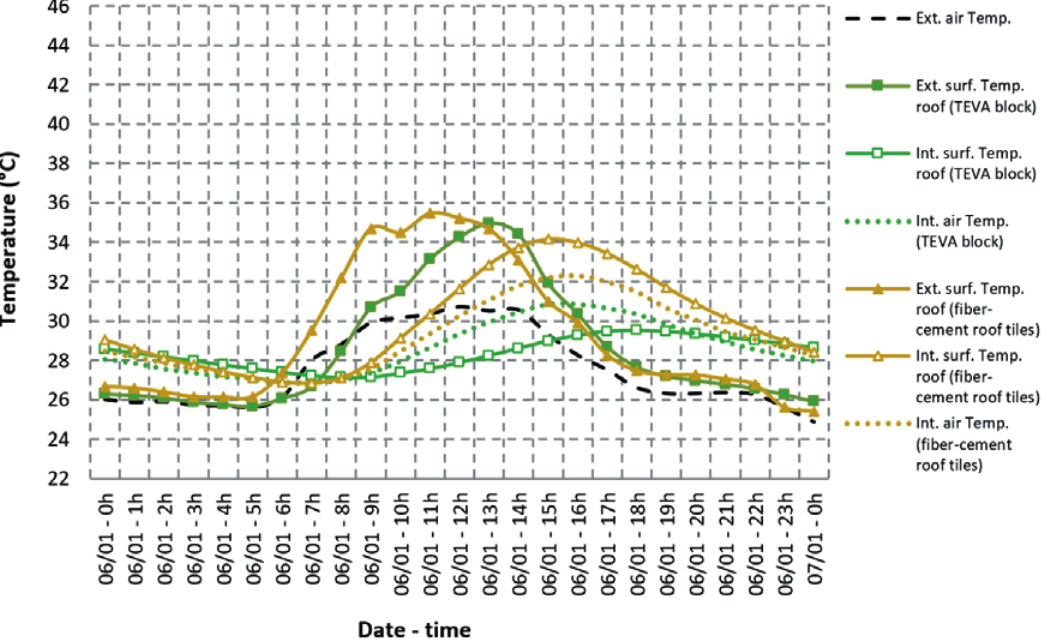
Thermal behavior of the prototype with a green roof with TEVA blocks on the slab and of the prototype with fiber-cement roof tiles on the slab, on the chosen typical summer